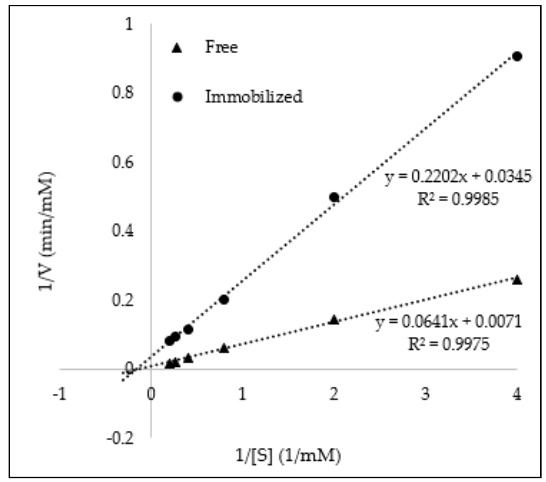
Figure 4. Lineweaver–Burk plot of immobilized GOx activity.